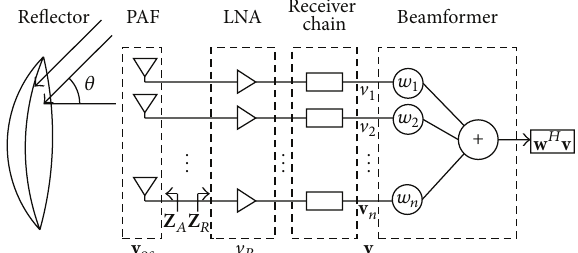
Figure 2: System diagram from arrays to beamformer.